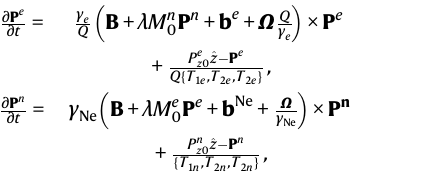
Fig.6 |Calibrationofthecomagnetometer.a Thecomagnetometerisrotatedby a rotary platform. The sensitive axis ( ^ y ) of comagnetometer is directed along dif- ferent direction. Hence, the projection of Earth rotation along ^ y can be used to calibratethecomagnetometer. β isthelatitudeofthelab, α istheorientationangle